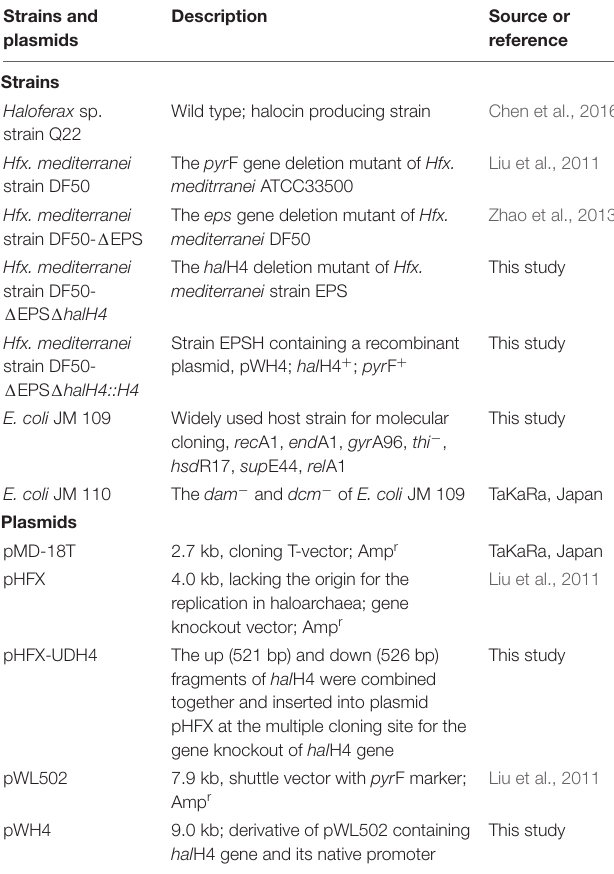
TABLE 1 | Strains and plasmids used in this study.